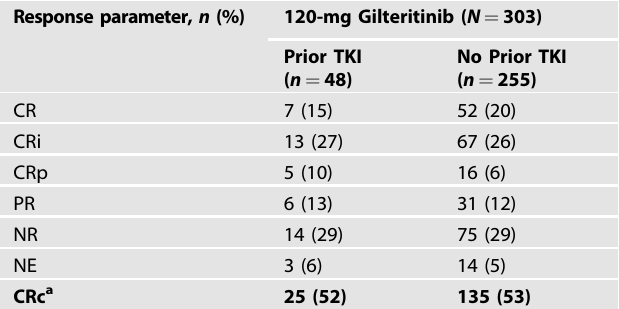
Table 4. Combined response outcomes in gilteritinib-treated R/R AML patients by prior TKI status from the CHRYSALIS and ADMIRAL